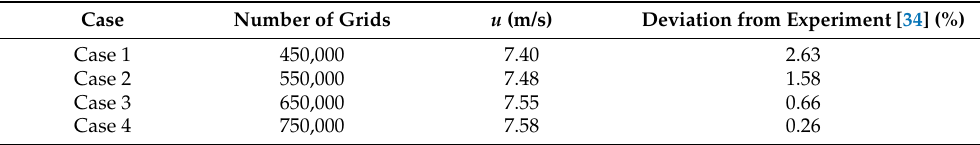
Table 2. The test of grid independence in the flow field.